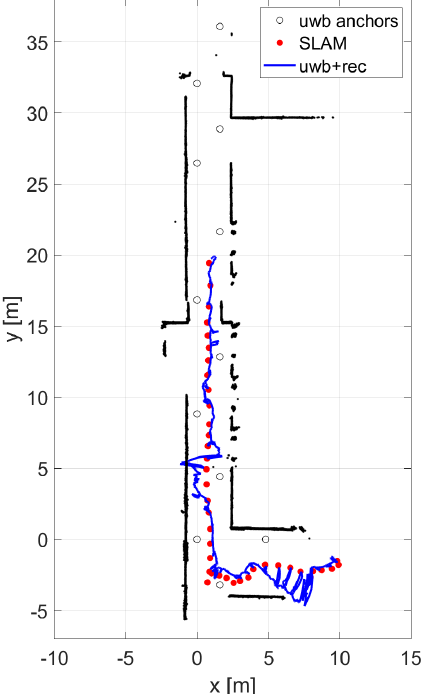
Figure 6. UWB+anchor recognition positioning.